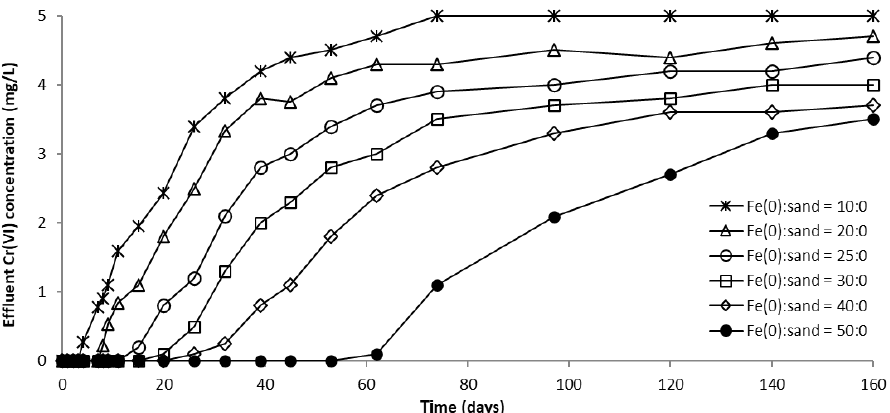
Figure 13. Cr VI concentration in column effluent vs. time for control columns packed with “Fe 0 only” reactive zone .